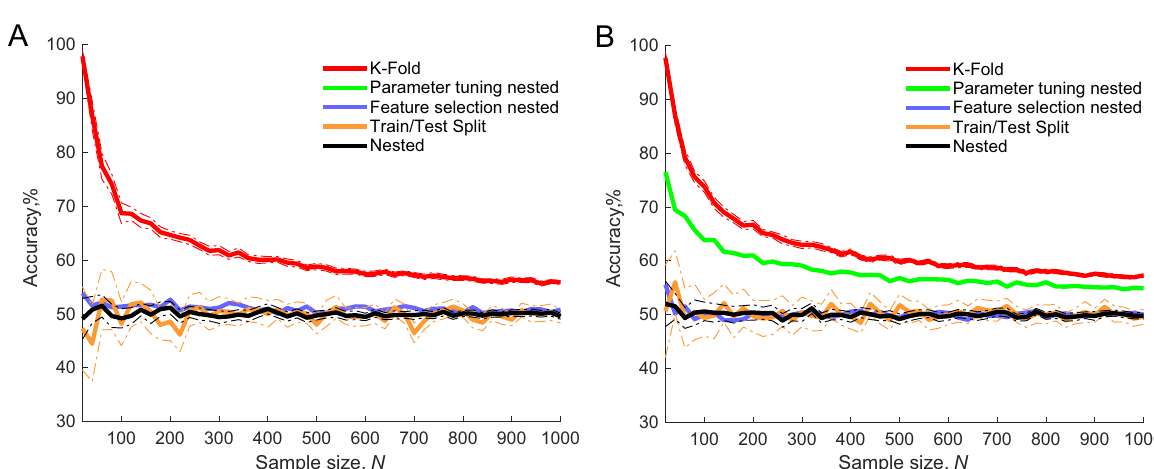
Fig 3. Gaussian noise classification accuracy distributions with different validation approaches. K-Fold, Nested, Train/Test Split and two types of partially nested validation methods used. Thick lines show mean validation accuracy and dash-dot lines show 95% confidence intervals for 50 runs. A : SVM-RFE feature selection and SVM classification. B : t -test feature selection and logistic regression classification.